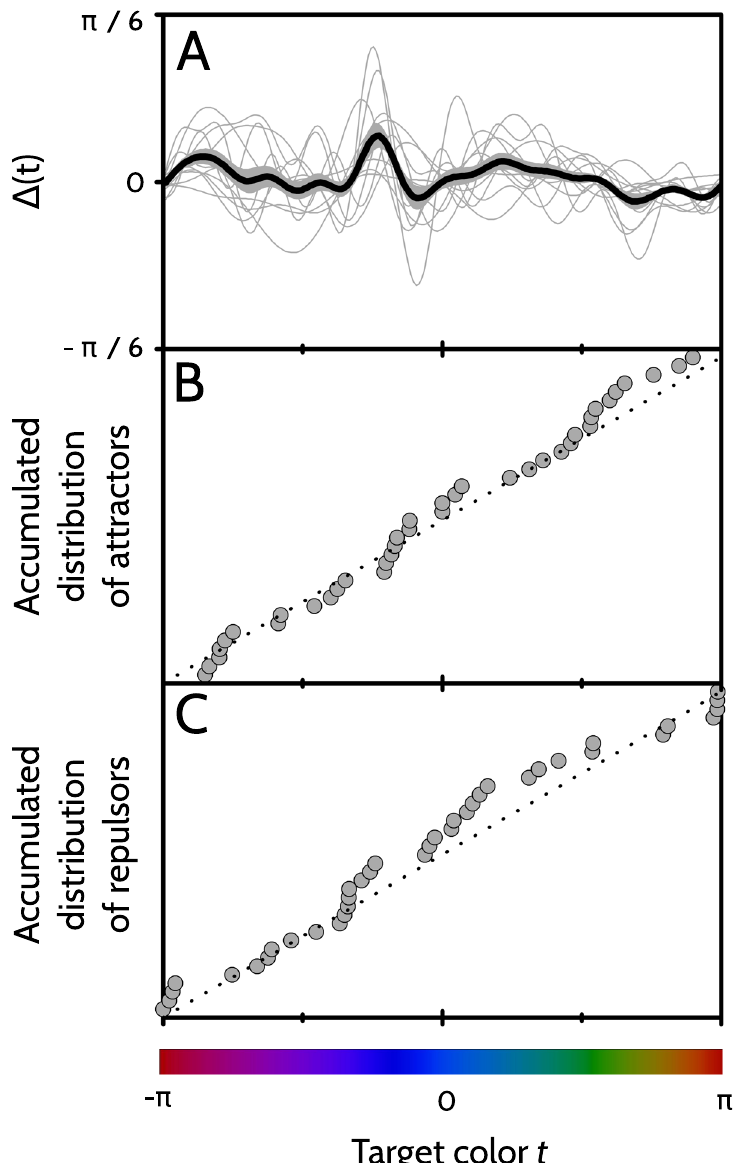
Fig 6. Analysis of attractors and repulsors for the collection of sampled players. A: Thick line: Sample average of the fitted error h Δ ( t ) i . Gray area: Region of values contained in h Δ ( t ) i ± standard error of the sample mean. Thin lines: individual fits Δ ( t ) for each of the 11 players. B: Data points: Empirical cumulative distribution function of the set of attractors obtained from the 11 players. Dotted line: Accumulated distribution expected for a uniformly distributed process. C: Same as B, for repulsors. In B and C, the vertical axis extends from 0 to 1.